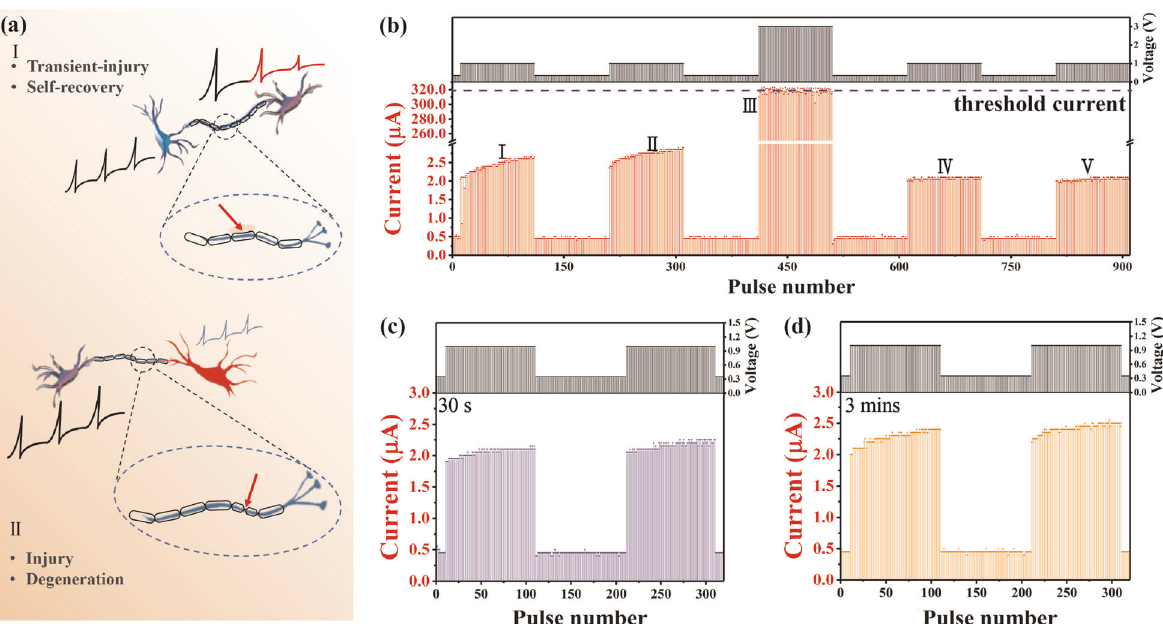
Fig. 5 Emulation of the nerve injuries by mild stimuli. a The schematic diagram for the nerve injuries caused by mild and severe stimuli. b Response of the post-synaptic current to mild stimuli. The dash line shows the threshold current for the functional loss of the nerve system. The self-recovery process for the nerve injuries in c 30 s and d 3 min. Fully recovery of the synaptic behavior can be achieved in 3